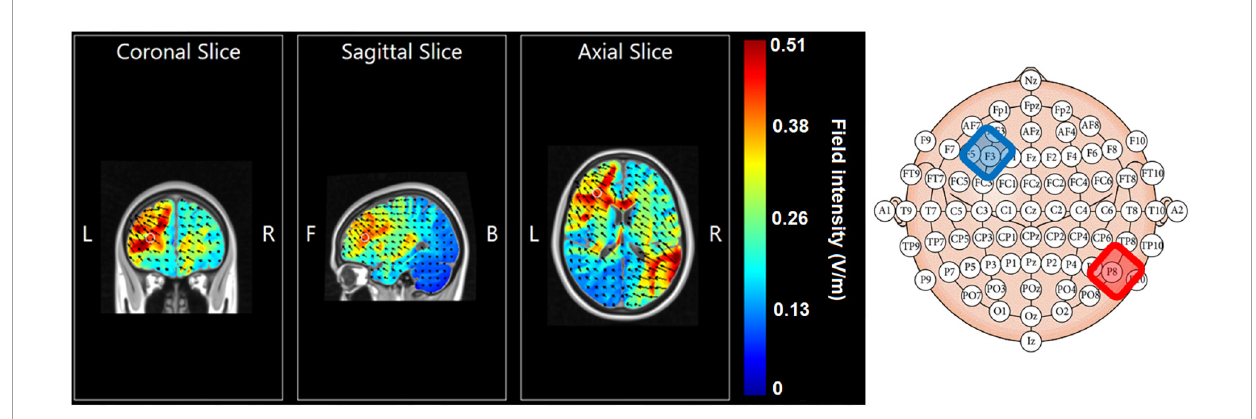
FIGURE2 Electrical field modeling of cathode F3 (in blue) – anode P8 (in red) montage using HD Explore, Soterix Medical and their head